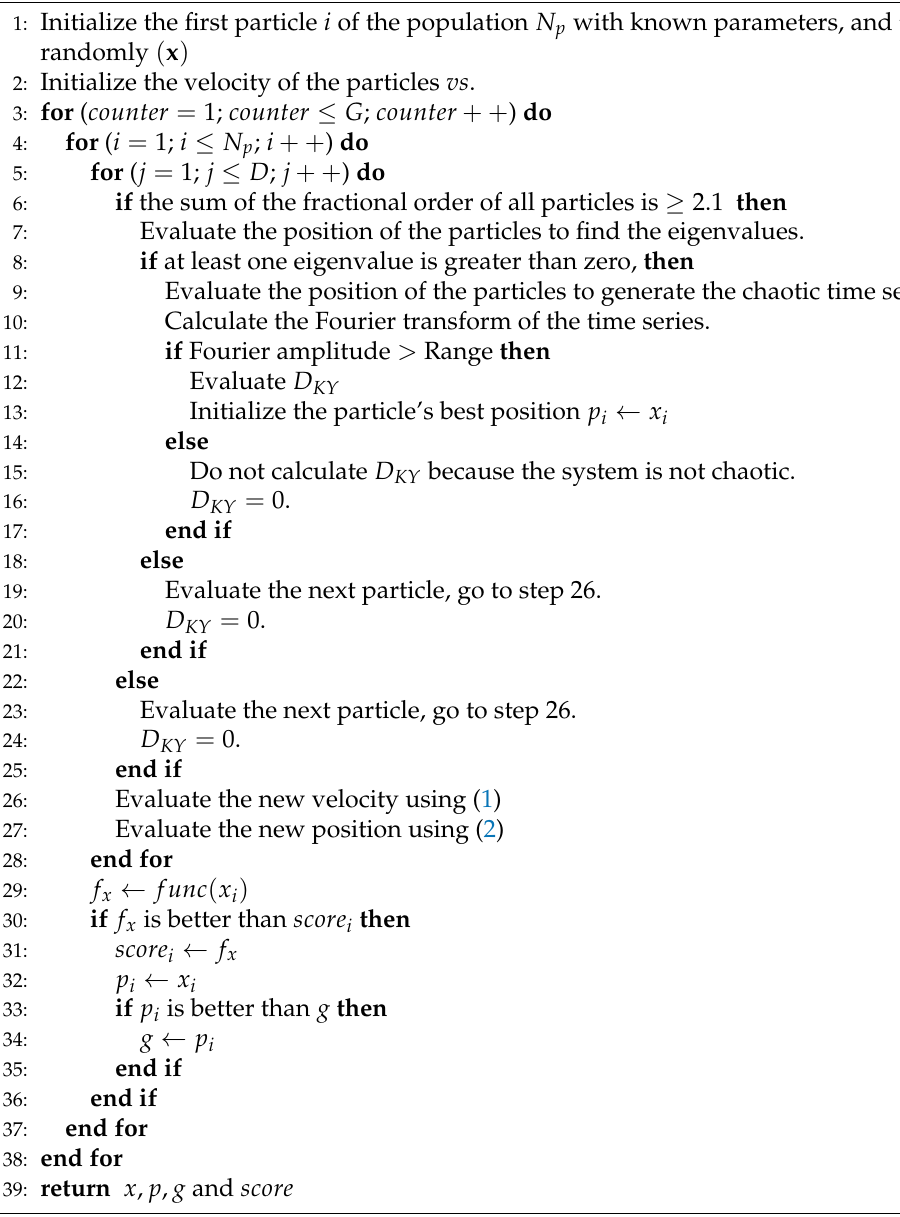
Algorithm 1 Optimization of a fractional-order chaotic system by